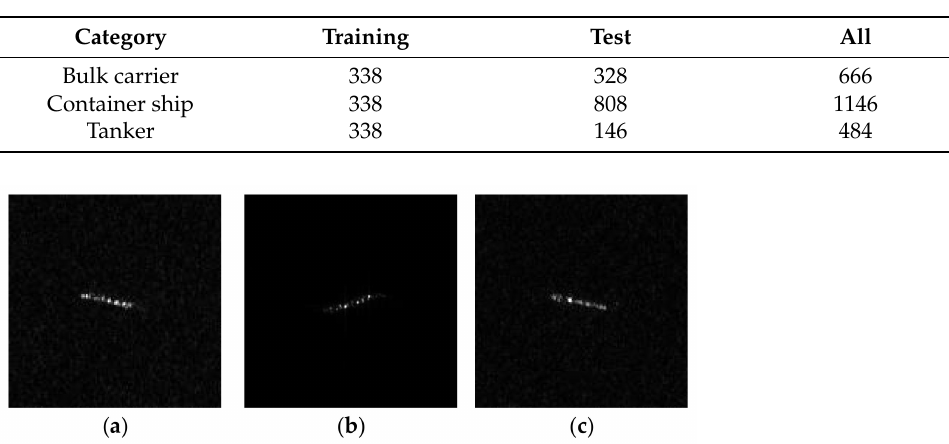
Table 2. Training and test set of the OpenSARShip-1.0 dataset.